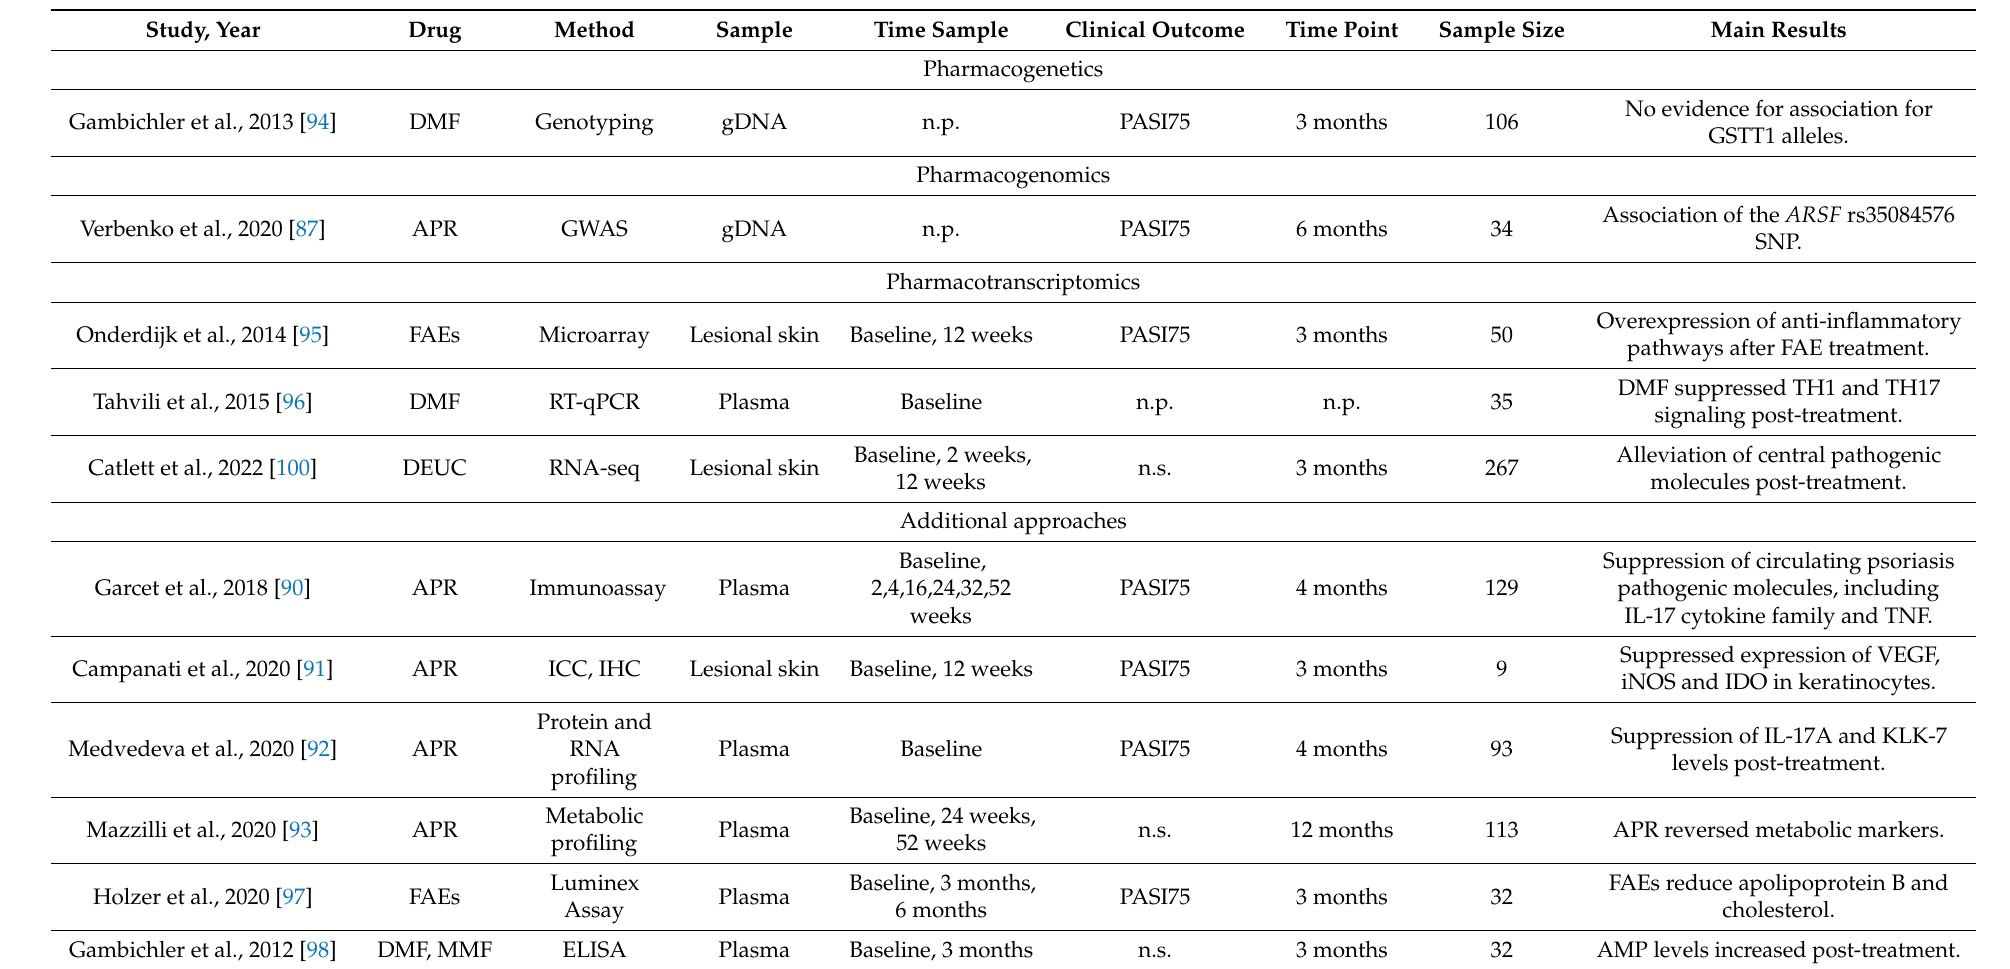
Table 2. Pharmaco-omic approaches applied in small